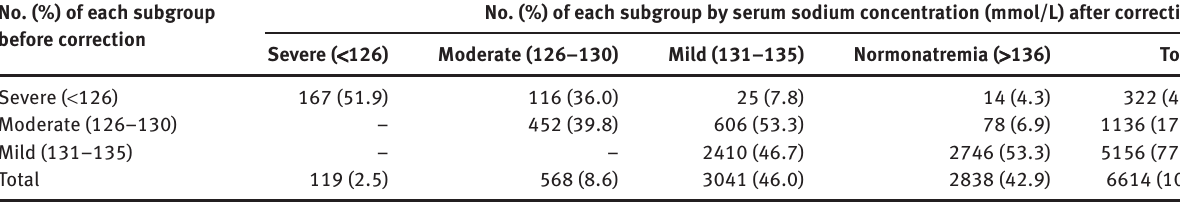
Table 3: Comparison of the pairwise results for degree of hyponatremia between sodium concentrations before and after correction. No. (%) of each subgroup before correction